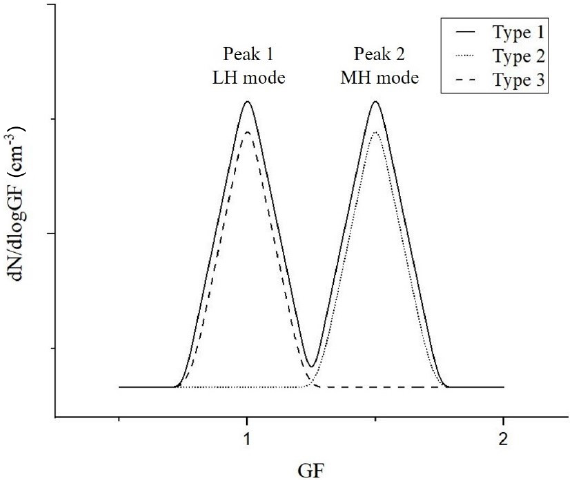
Figure 10. Schematic plot of three aerosol types: Type 1 (externally mixed aerosol; solid line), Type 2 (internally mixed aerosols with GF > 1 . 1; dotted line), and Type 3 (internally mixed with GF < 1 . 1; dashed